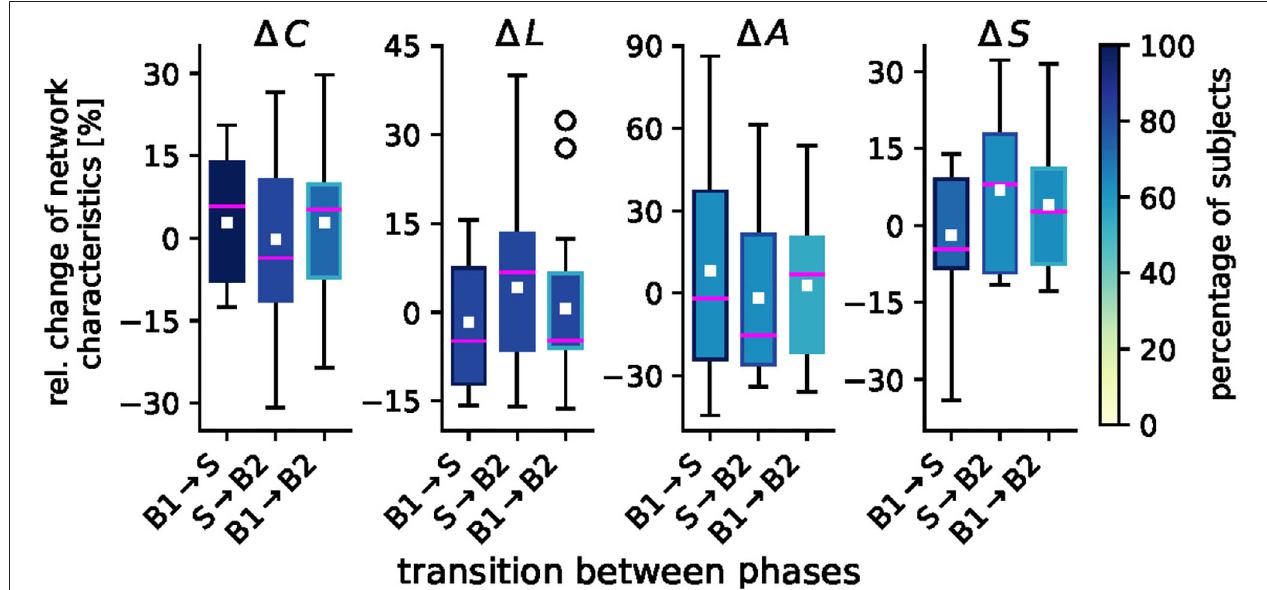
FIGURE 3 | Sample distributions of taVNS-related alterations in global network characteristics (global clustering coefficient C , average shortest path length L , assortativity A , and synchronizability S ). Boxplots of significant relative changes in network characteristics 1 = ( M l − M k ) / M k , where M k and M l denote placeholders for the temporal average of the respective characteristics from phase k and phase l . Bottom and top of a box are the first and third quartiles, and the magenta band and the white square are the median and the mean of the distribution. The ends of the whiskers represent the interquartile range of the data. Outliers are marked by a ◦ sign. Color coding of boxes according to the percentage of subjects for whom we obtained significant changes in global network characteristics on a per-subject